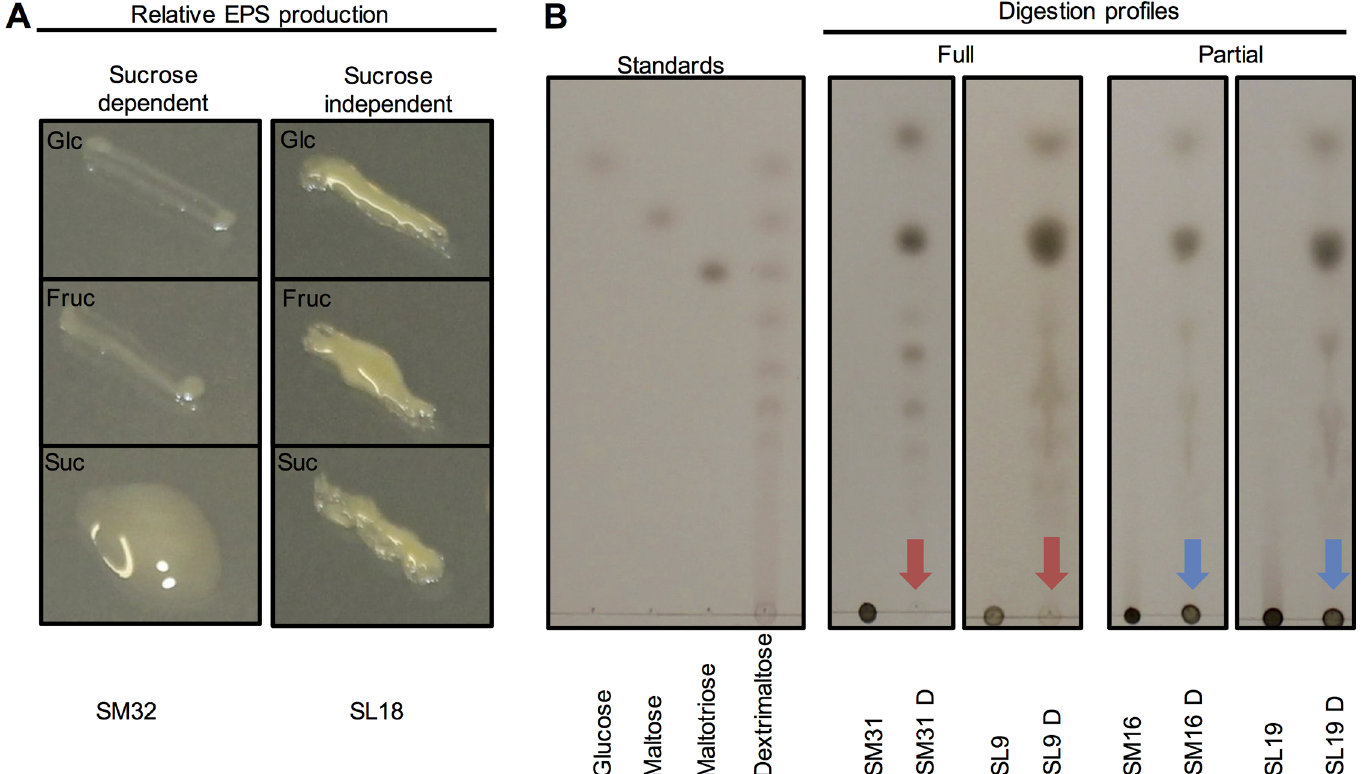
Fig 2. Polysaccharide accumulation and susceptibility to dextranase treatment. A – Sugar dependent or independent EPS production by bacteria grown on glucose, fructose or sucrose. B — Dextranase treatment of EPS. Full digestion is indicted by motile oligosaccharides in comparison to the undigested control; Partial digestion is indicated by an immobile spot at the origin in addition to motile oligosaccharides; Undigested EPS is indicated by no motile